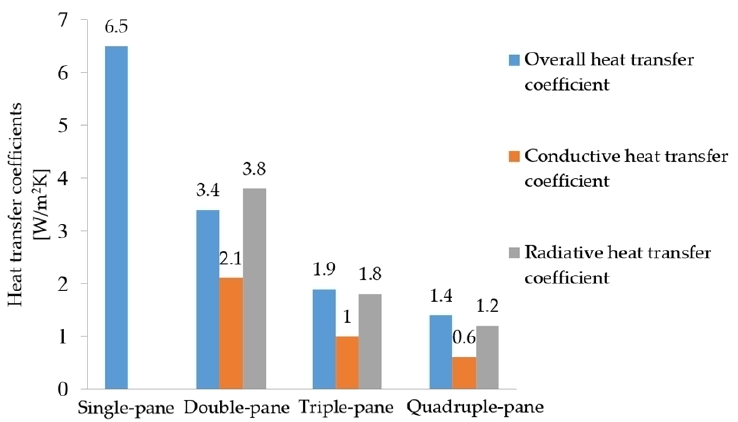
Figure 2. Variation of heat transfer coefficients depending on the number of panes (summarized data from cited papers).